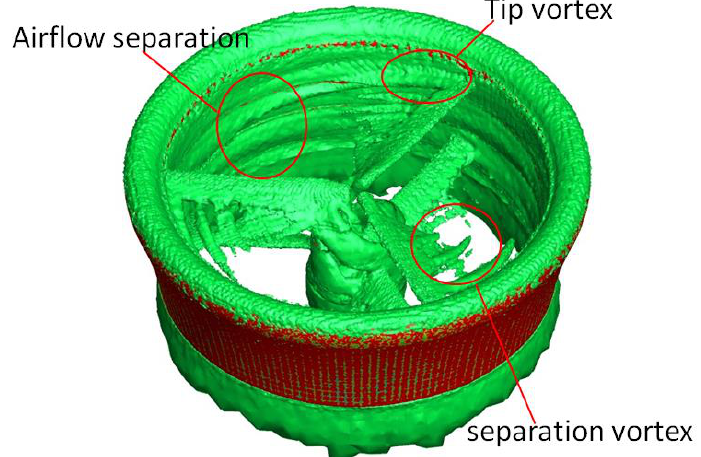
Figure 13. Vorticity